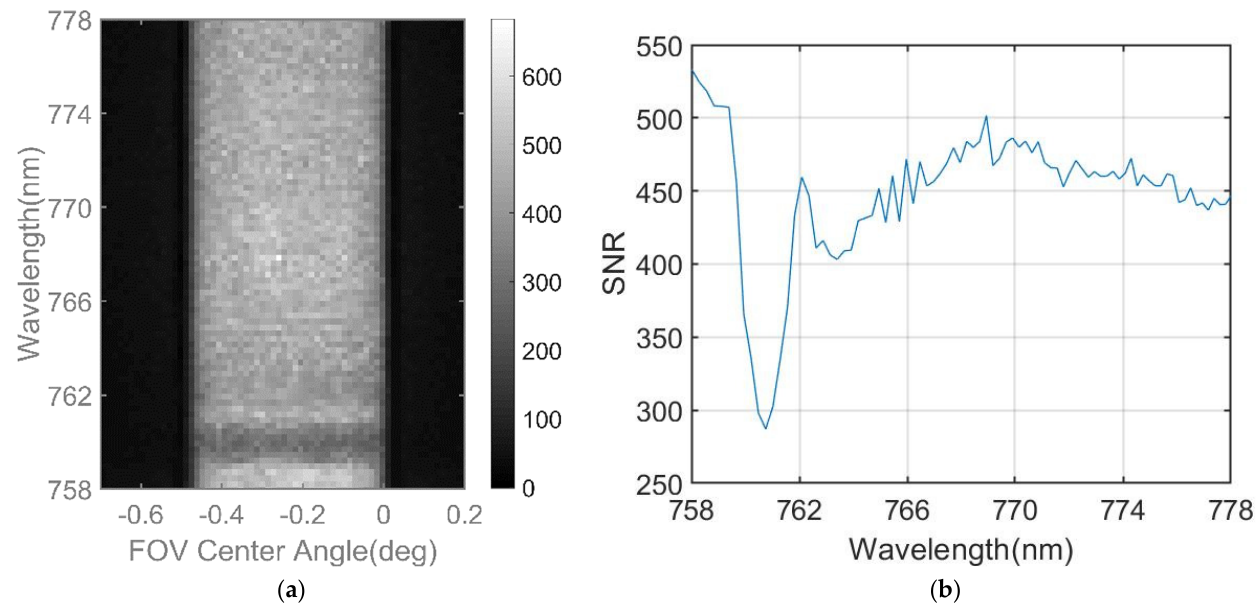
Figure 20. SNR of the 100 frames of data collected at 15:41 on 9 October ( a ) and the mean SNR of the full imaging area ( b ).